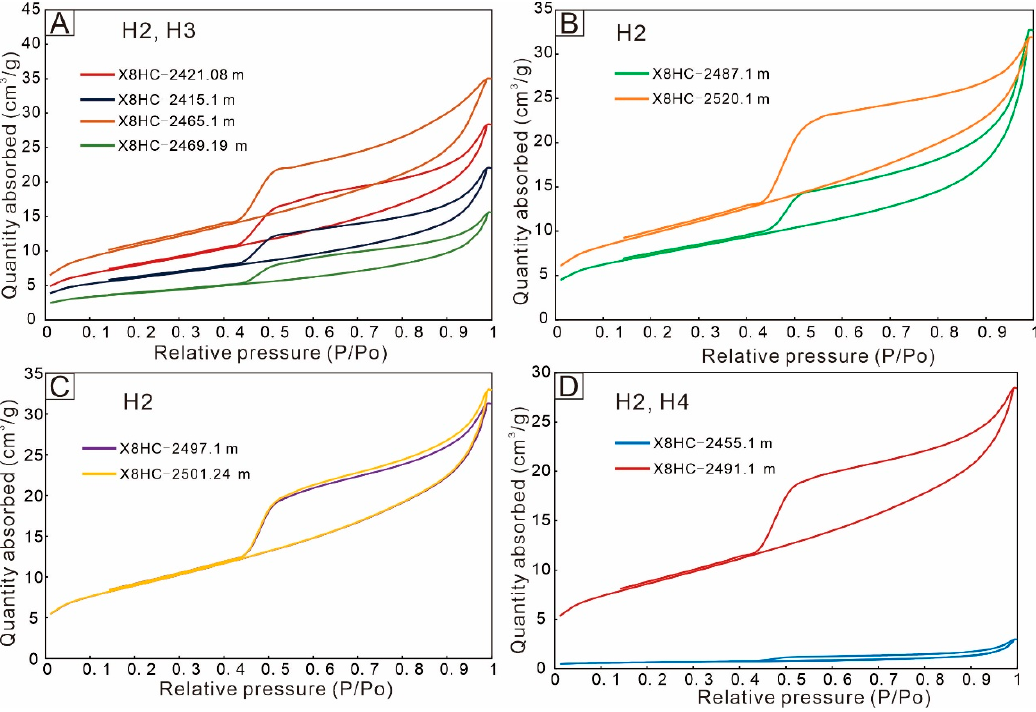
Figure 13. Hysteresis patterns and their corresponding pore shapes (modified from Sing [76]).